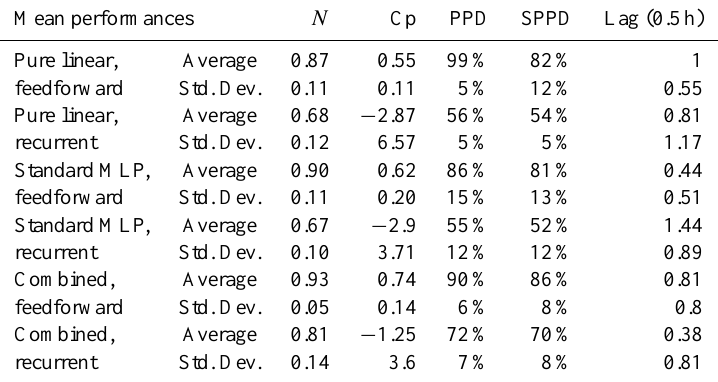
Table 1. Mean performances of assessed models. Performances are synthesized as it will be shown in Sect. 3.5. Lag is the delay between the maximum observed discharge and maximum forecast discharge. Mean performances